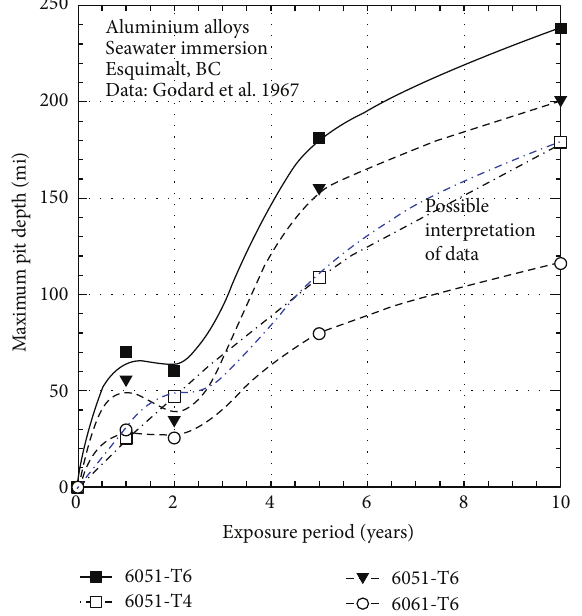
Figure 14: Data and fitted trends for several 6xxx series aluminium alloys exposed to seawater immersion conditions at Esquimalt, BC, Canada. These are different sets of data to those in Figure 13. The changeover to mode 2 occurs at around 2-3 years of exposure. Data from Godard et al. [16].